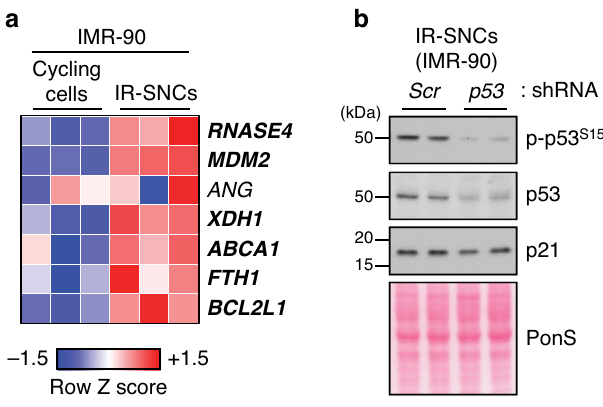
Fig. 8 RNASE4 expression is elevated in human senescent fi broblasts. a Heatmap of SASE gene expression in IR-senescent IMR-90 cells and proliferating counterparts. Row Z-scores based on RNA-seq data are depicted. Bolded genes are signi fi cantly upregulated in IR-SNCs. b Western blot analysis of senescent IMR-90 cells harvested three days after infection with p53 -shRNA or Scr- shRNA. Western blot result is representative of 2 independent experiments. Source data are provided as a Source Data fi